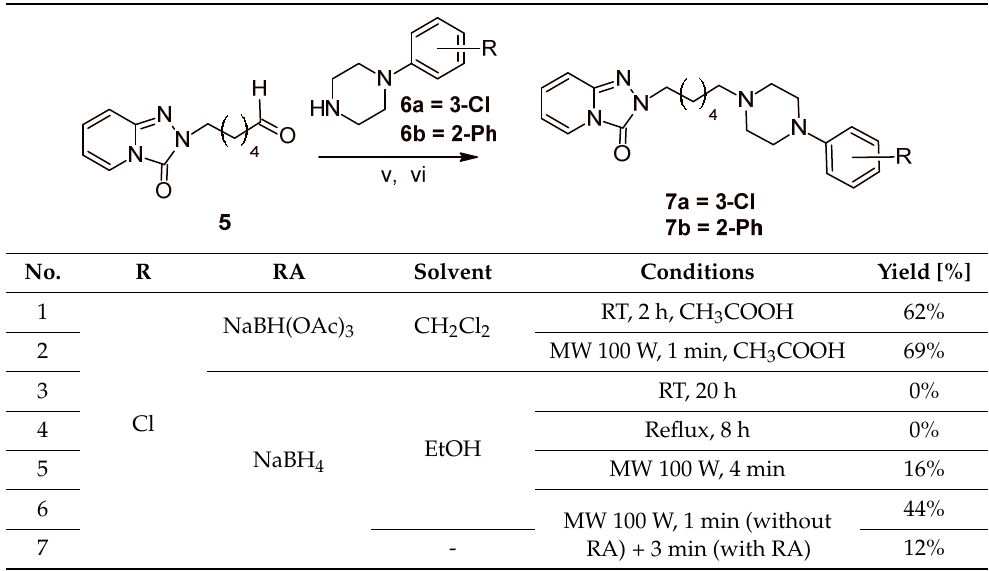
Table 1. Development of steps v and vi of synthesis of 7a and 7b .